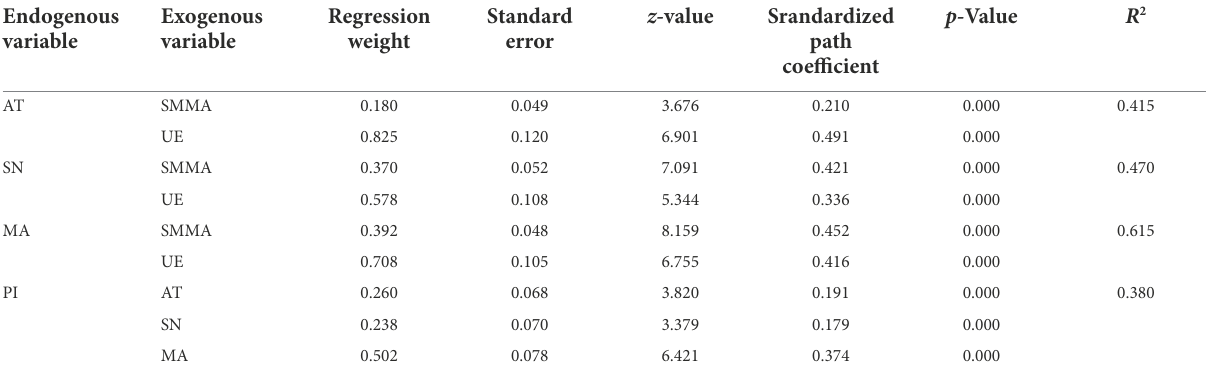
TABLE 6 Regression